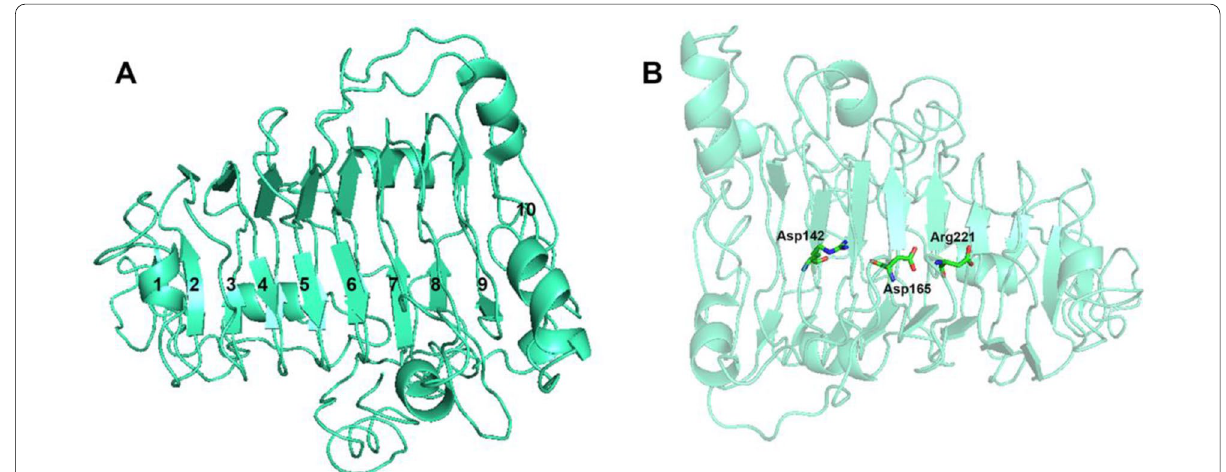
Fig. 3 The homology model of ErPelPL1 ( A ) and the key residues for substrate binding ( B )